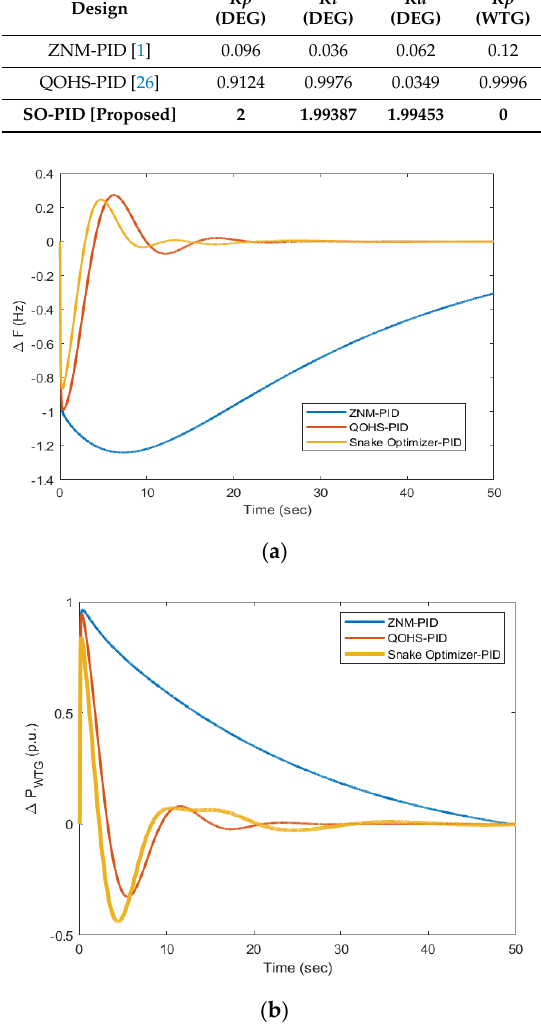
Figure 7. ( a , b ) Output of diesel–wind isolated system for 1.0 p.u. step load alteration.